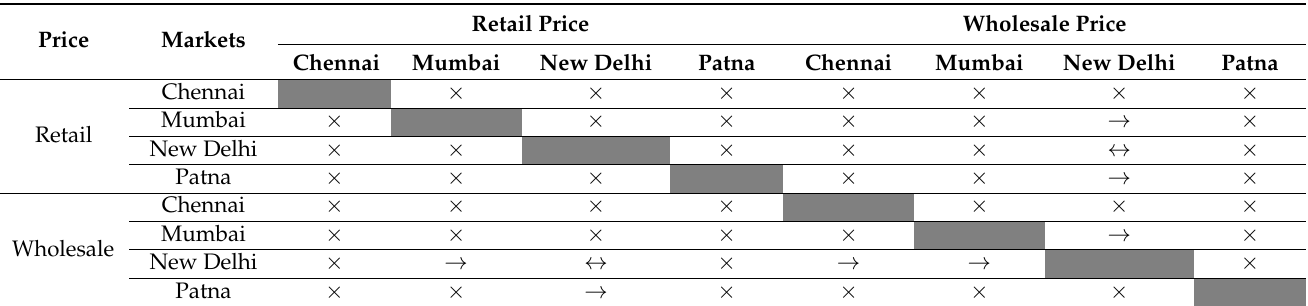
Table 10. Price transmission between the rice markets by Granger causality